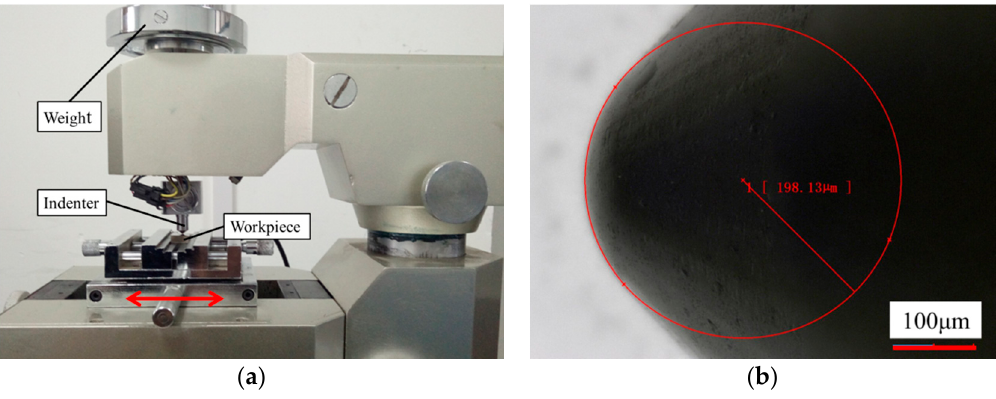
Figure 9. The set-up and indenter for the measurement of the friction coefficient. Table 4. Design of the experiment for the measurement of the friction coefficient.